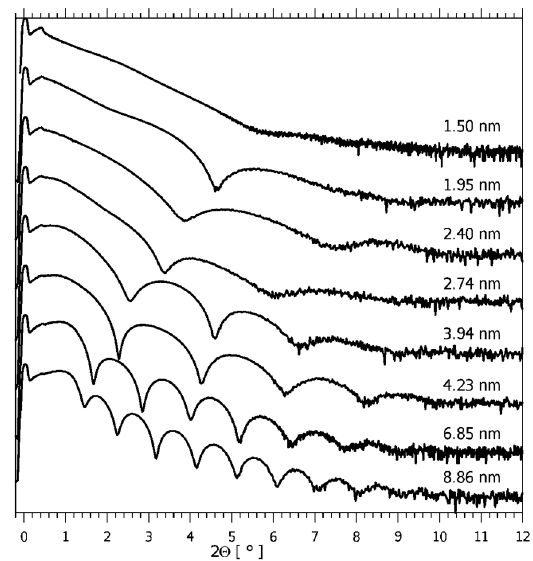
Figure 3. X-ray reflectivity (XRR) spectra of W monolayers.